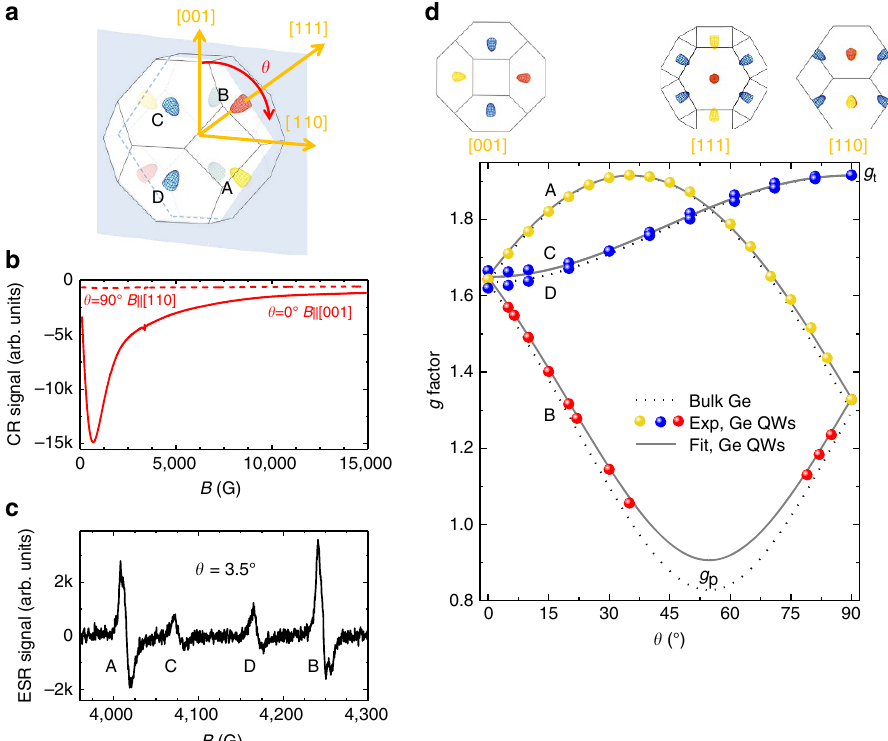
Figure 2 | CESR of Ge QWs. ( a ) Brillouin zone of bulk Ge. y is the angle between the [001] crystallographic direction and the magnetic field B, which scans towards the [110] direction. The ellipsoidal isoenergetic surfaces of the conduction band at the L point are also shown. ( b ) CR signal in Ge QWs measured at T ¼ 2K for y ¼ 0 (cid:2) (solid red line) and y ¼ 90 (cid:2) (dashed red line). ( c ) ESR signals from conduction electrons in Ge QWs measured at T ¼ 2K and y ¼ 3.5 (cid:2) , after subtracting a linear background. ( d ) Values of g factor measured from the ESR peaks at T ¼ 2K in 20nm Ge QWs as a function of y . The correspondence between the angle y and the main crystallographic directions are highlighted in the upper part of the figure. Labels from A to D establish the relation of the branches both with the peaks in c and with the valleys in a . g p and g t are the lowest and the highest values of g , respectively. Upper part: sketches of the Brillouin zone when B is directed along the main crystallographic